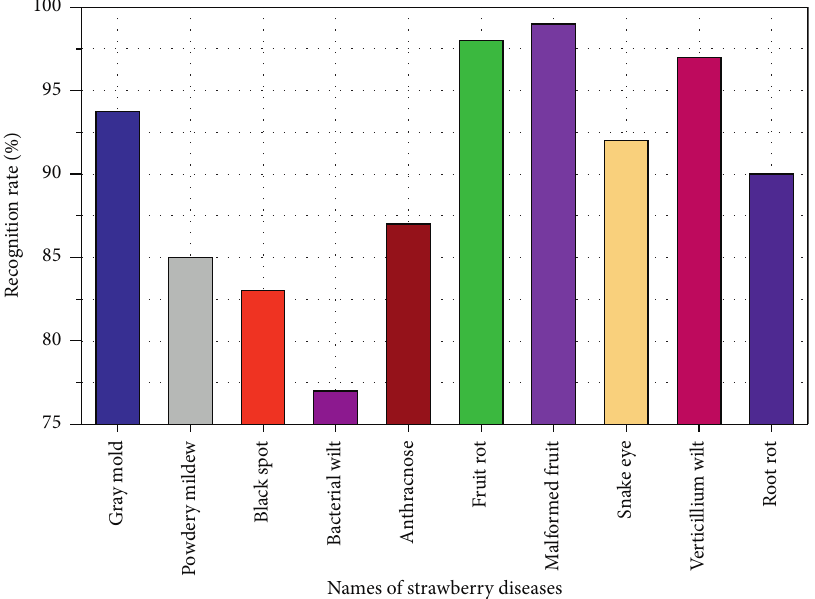
Figure 8: Comparison of recognition rate of strawberry